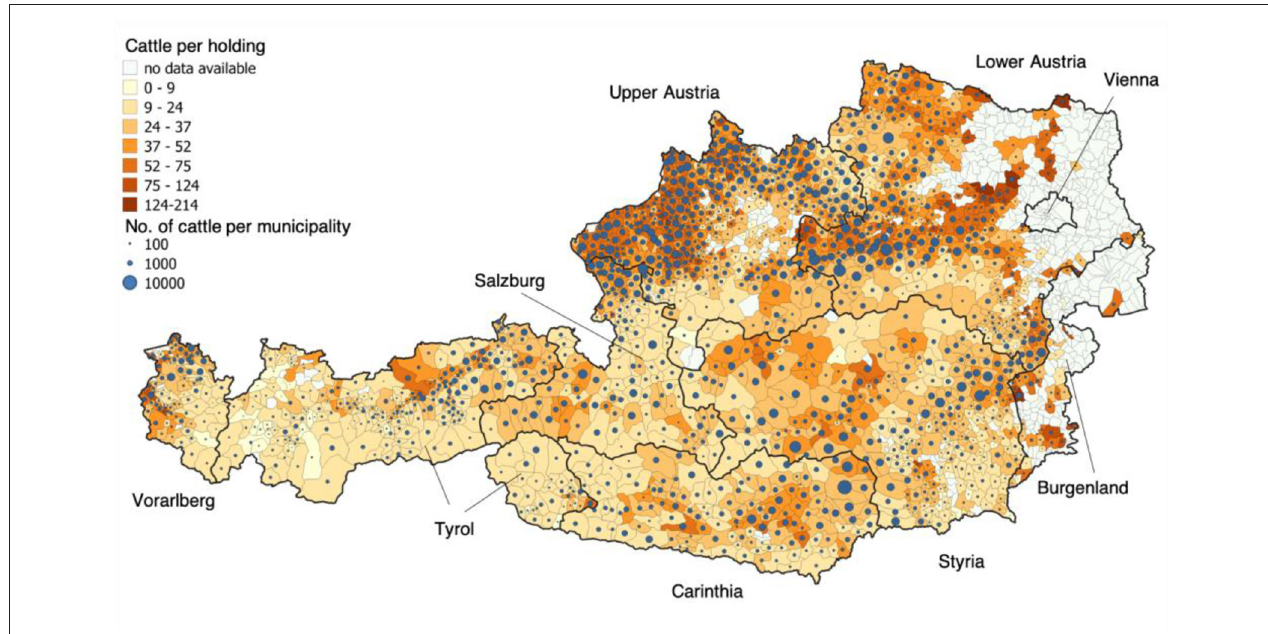
FIGURE 1 | Regional distribution of Austria’s cattle population [data from 2017 (9)]. The colors of the municipalities shown depend on the average number of cattle per holding. The size of the blue dots represents the absolute cattle number per municipality. The recent available data from the year 2017 were used for this figure ( 4).